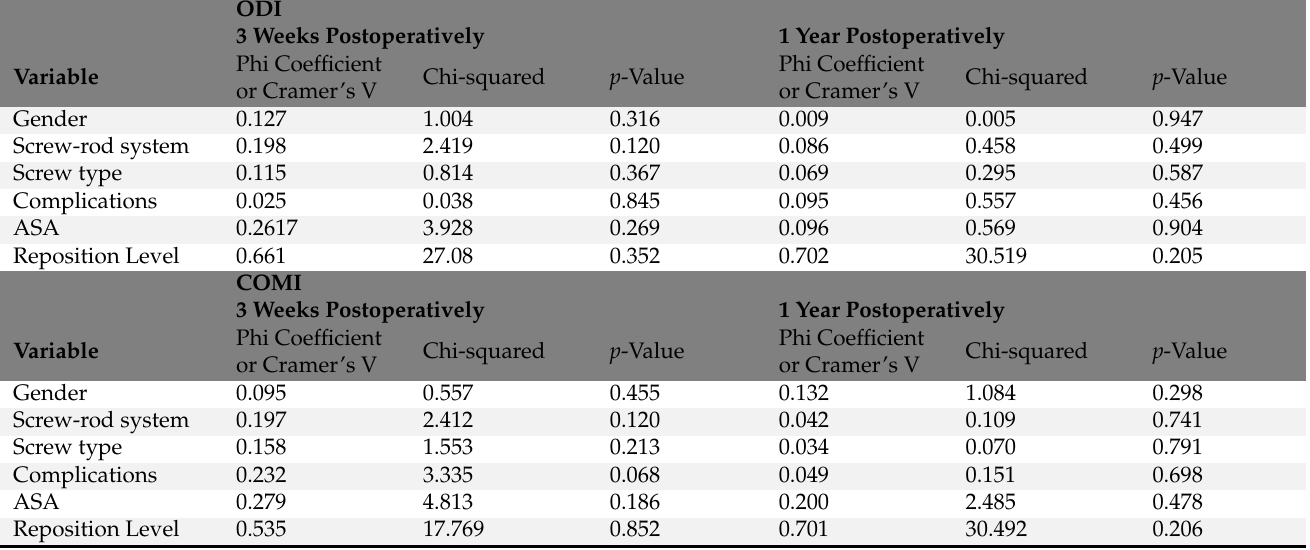
Table 2. Analysis of associations between PROMs and categorical study variables. Interpretations of Cramer’s V and phi coefficient are made as follows: very strong correlation (>0.25), strong correlation (>0.15), moderate correlation (0.10), weak correlation (>0.05), no or very weak correlation